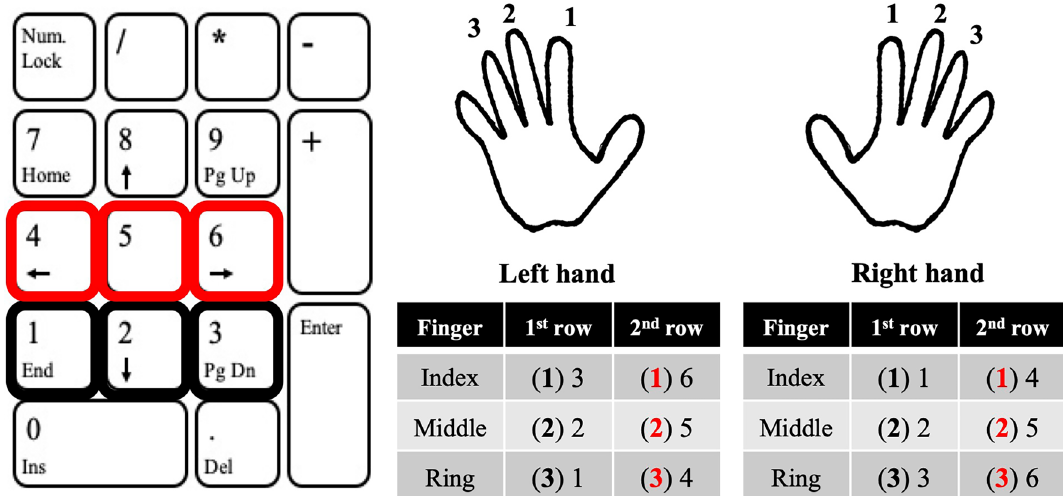
Figure 2. Experimental setup of the numeric keypad. The index (1), middle (2), and ring (3) fingers of the right or left hand were placed on the numeric keyboard’s lower line, covered with a virtual partition. The digits 1, 2, and 3 corresponded to ‘1’, ‘2’, and ‘3’ keys for the right hand and to ‘3’, ‘2’, and ‘1’ keys for the left hand. For the 3rd and 4th conditions, the second line of the numeric keyboard was also involved and was indicated with red numbers on the screen. In this case, the digits 1, 2, and 3 corresponded to ‘4’, ‘5’, and ‘6’ keys for the right hand and to ‘6’, ‘5’, ‘4’ keys for the left hand. Images within the figure were drawn by János Négyesi and were scanned using Microsoft Office Lens application (Microsoft, Redmond, Washington,